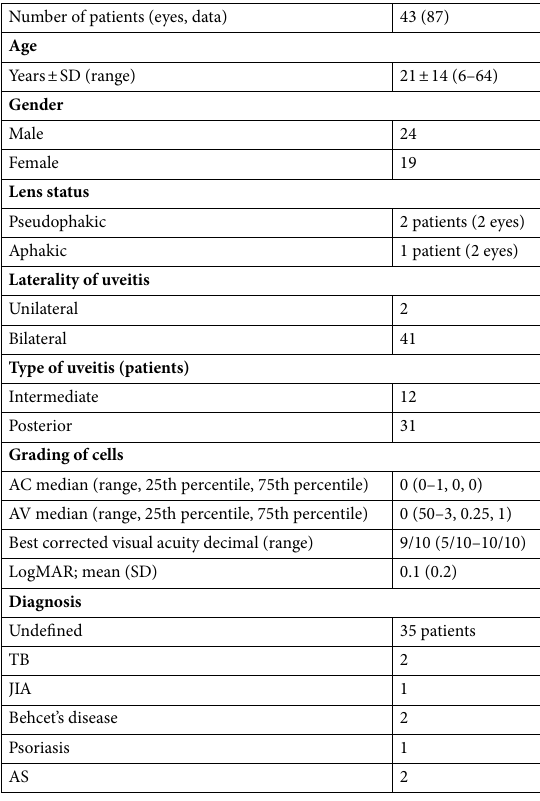
Table 1. Demographic and clinical characteristics of the study population. AC anterior chamber, AV anterior vitreous, BCVA best corrected visual acuity, LogMAR logarithm of the minimum angle of resolution, TB tuberculosis, JIA Juvenile Idiopathic Arthritis, AS ankylosing spondylitis.